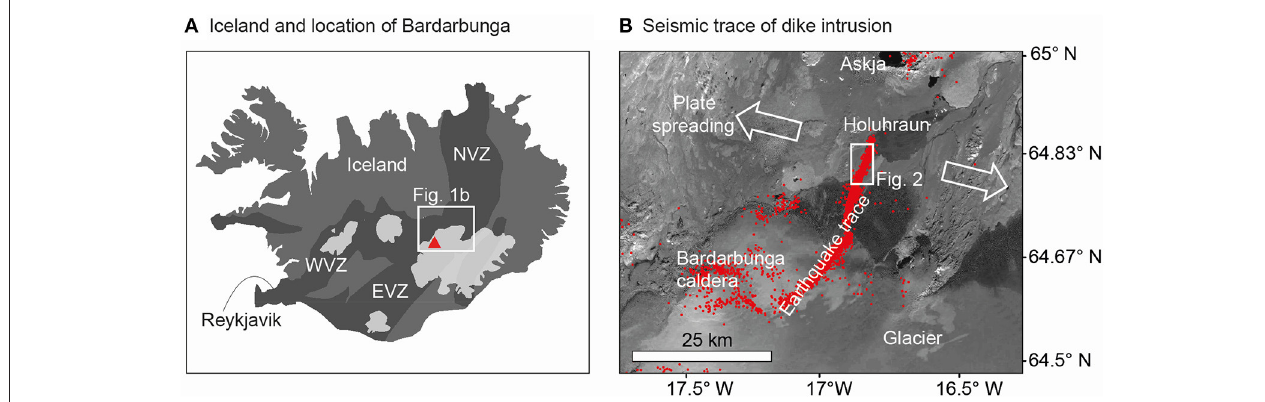
FIGURE 1 | Study area– (A) Iceland and locations of the volcanic zones, namely, the Northern Volcanic Zone (NVZ), Western Volcanic Zone (WVZ) and Eastern Volcanic Zone (EVZ). The red triangle depicts the location of the Bardarbunga central volcano, under Vatnajökull glacier (glaciers are light gray). (B) Northern sector of Vatnajökull glacier within the Bardarbunga caldera. Red dots depict earthquake locations (Icelandic Meteorological Office) recorded over a time span of 3 weeks, indicating the path of the intruding dike. The 2014/2015 Holuhraun eruption occurred at its northern end and produced lava flows covering 86km 2 (dark gray areas). Background image: WorldView-2, September 2015. The white box outlines the region shown in Figure 2D